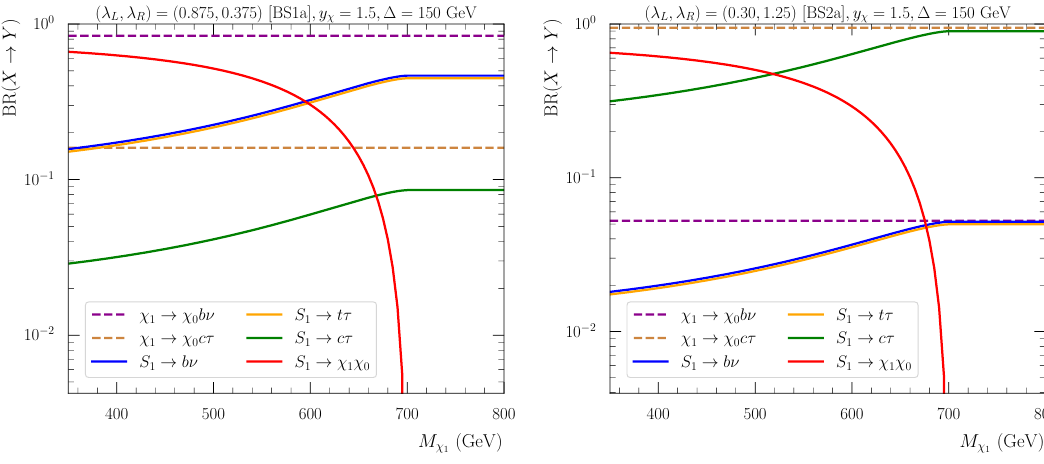
Figure 4 . Branching ratios for the S 1 and χ 1 states as a function of the χ 1 mass. The mass difference between χ 1 and χ 0 is kept at 150 GeV, y χ = 1 . 5 , and the other parameters correspond to the BS1a (left) and BS2a (right) points defined in table